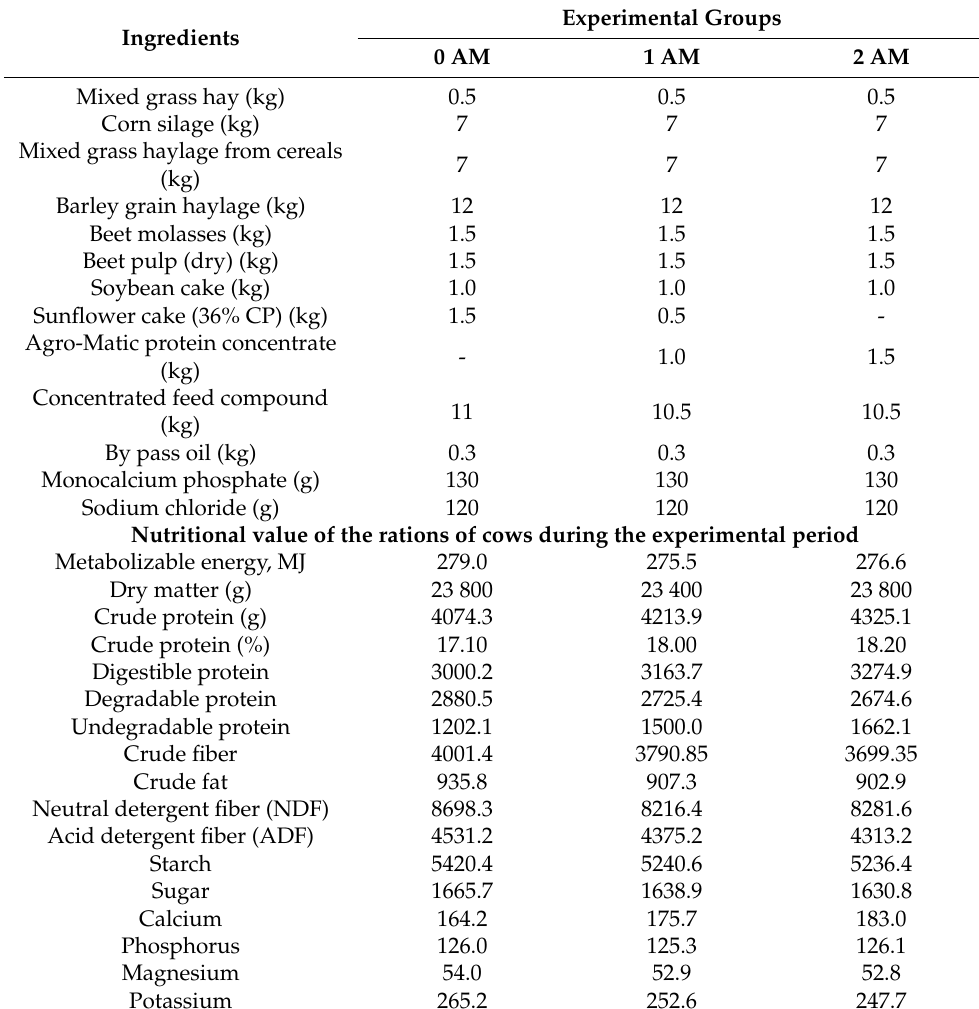
Table 1. Composition and nutritional value of the basic ration fed to the dairy cows during the experimental